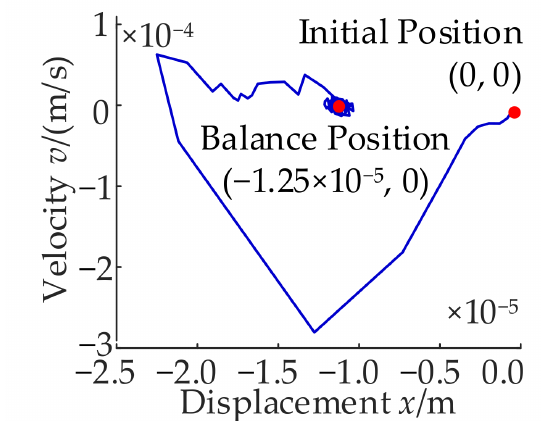
Figure 14. Phase trajectories of rotor by test when K p =